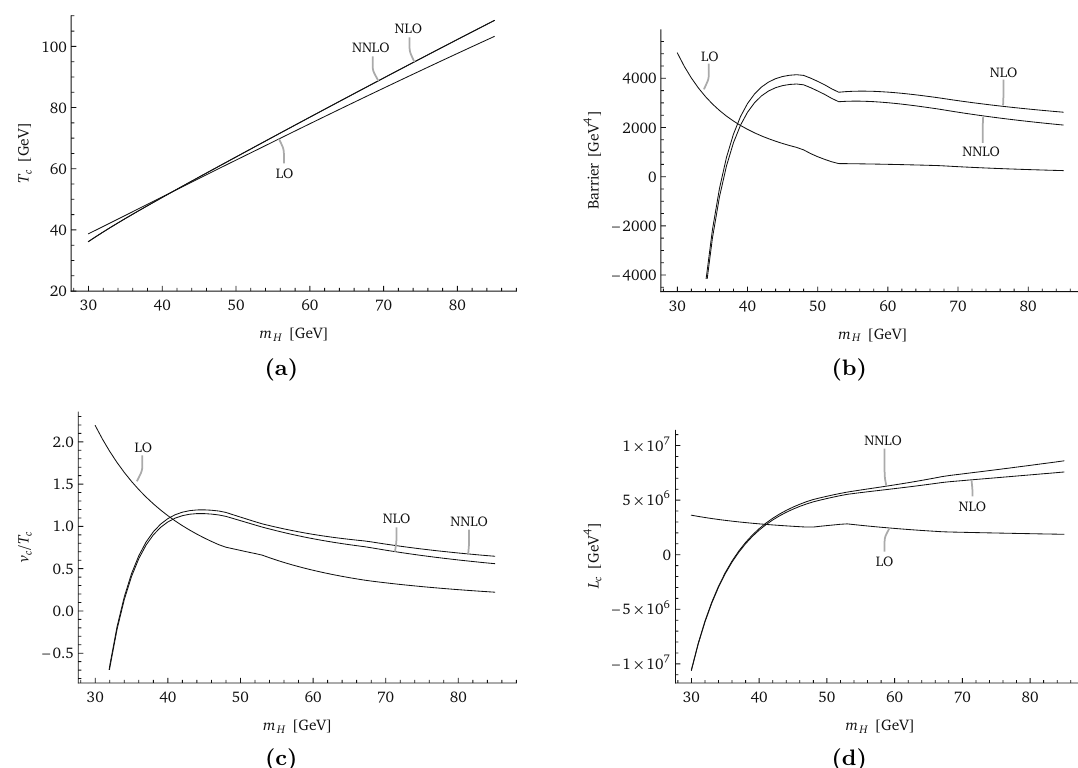
Figure 2 . Observables at T c for the gauge-invariant method. Plotted for different Higgs masses; with (a) the critical temperature, (b) the barrier height, (c) the phase transition strength, and (d) the latent